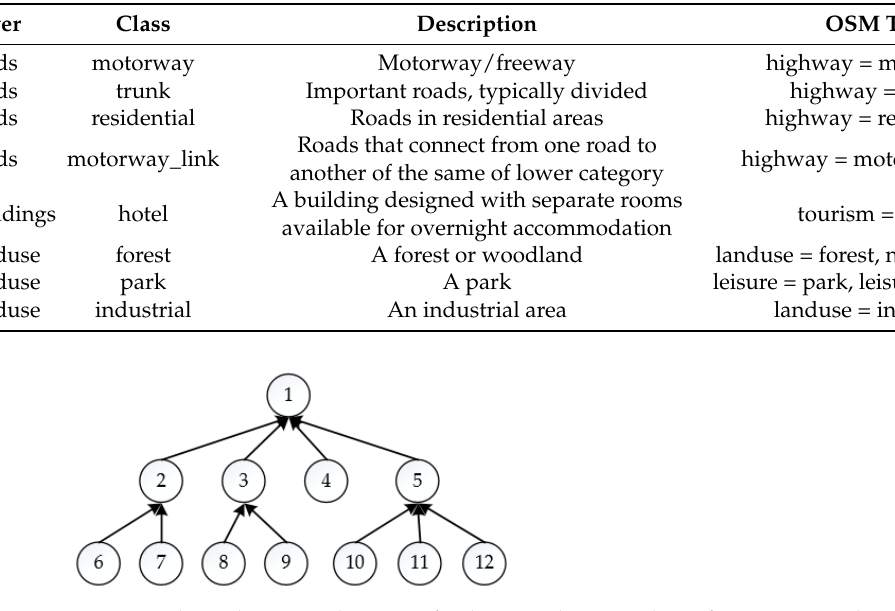
Figure 2. The architecture diagram of volunteered geographic information ontology.